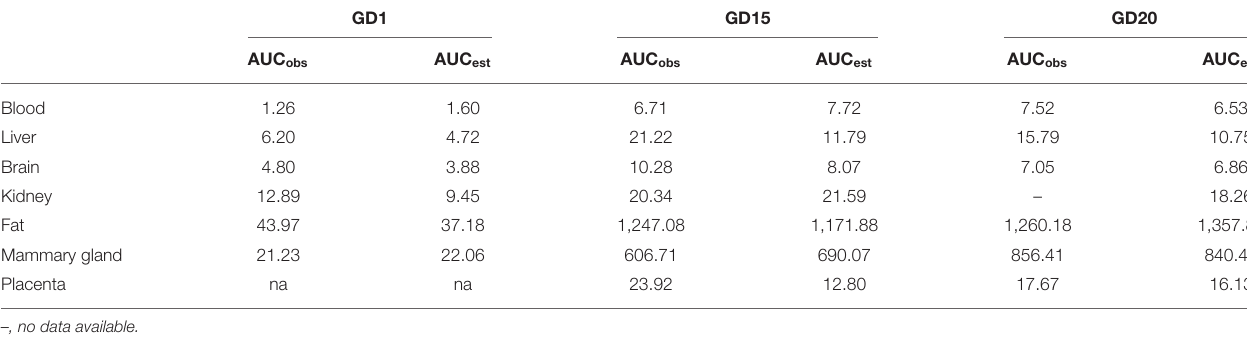
TABLE 4 | Area under the curve ( µ g h/ml or µ g h/g) of the observed concentrations (AUC obs ) and the estimated concentrations (AUC est ) for cis -permethrin in the blood and tissues of pregnant rats.